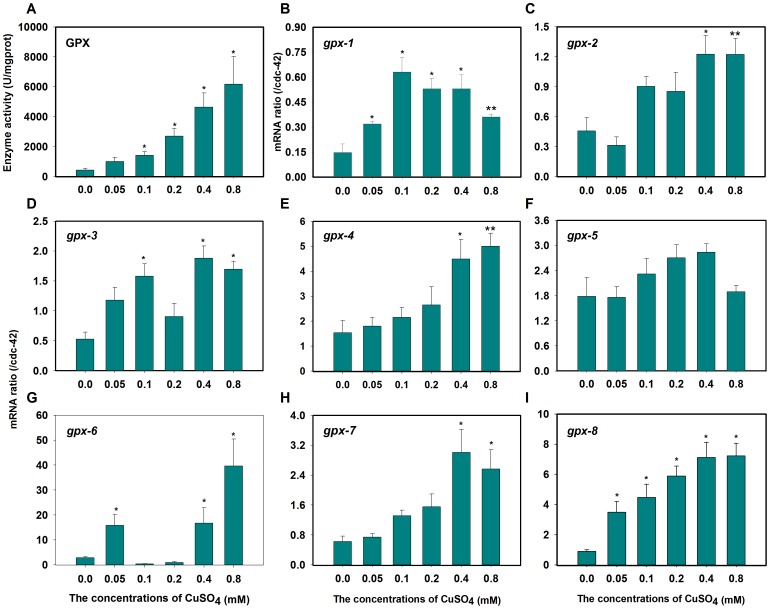
GPX activities or mRNA expression induced by copper in C. elegans.(A) The GPX activity was elevated when exposed to copper. Values are presented as the means ±SE (n = 3) in U mg−1 Pr. (B) gpx-1, (C) gpx-2, (D) gpx-3, (E) gpx-4, (F) gpx-5, (G) gpx-6, (F) gpx-7, and (G) gpx-8 expression ratios were each quantified in nematode N2 at different concentrations of copper and normalized with cdc-42. *P<0.05, **P<0.01 versus respective controls analyzed by t-test.